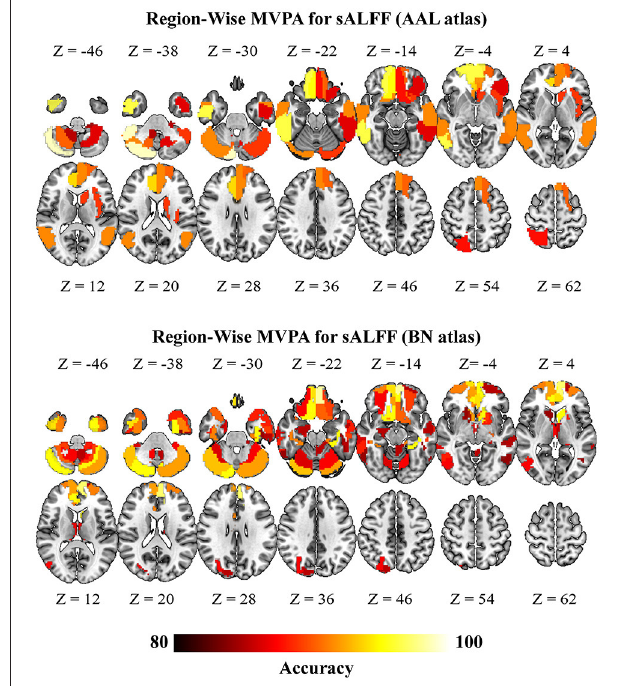
HC” using the static amplitude of low-frequency fluctuation (sALFF) ( p < 0.05, FWE for multiple comparison correction). DCM, Degenerative Cervical Myelopathy; HC, Healthy Controls; AAL, Anatomical Automatic Labeling; BN,